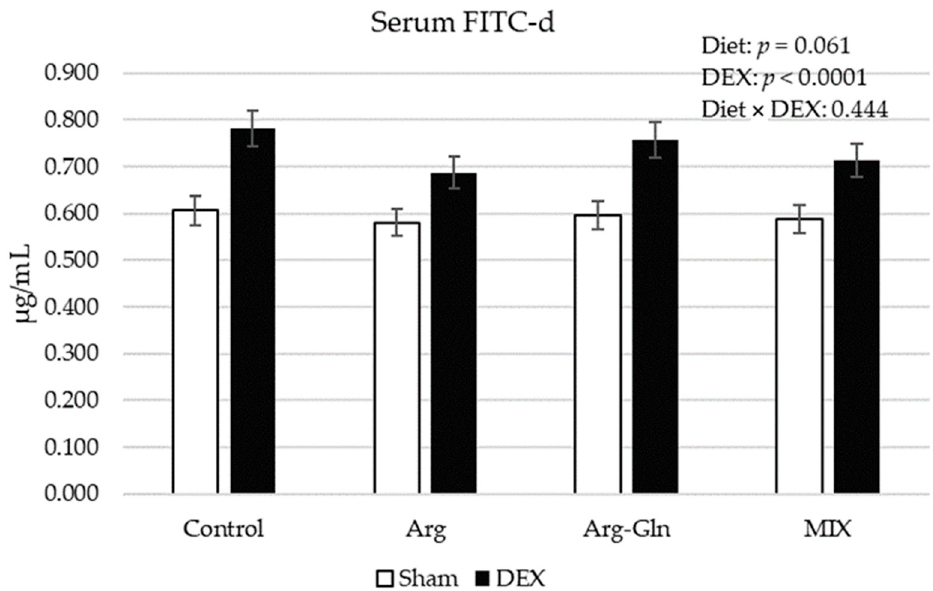
Figure 1. Serum concentration of FITC-d on day 21 of age. Error bars represent pooled standard error. FITC-d: Fluorescein isothiocyanate-dextran; MIX: A supplement that contained Arg, Gln, Thr, and grape extract; Diet × DEX: interaction of diet and DEX; DEX: Injected with dexamethasone; Sham: Injected with saline solution.